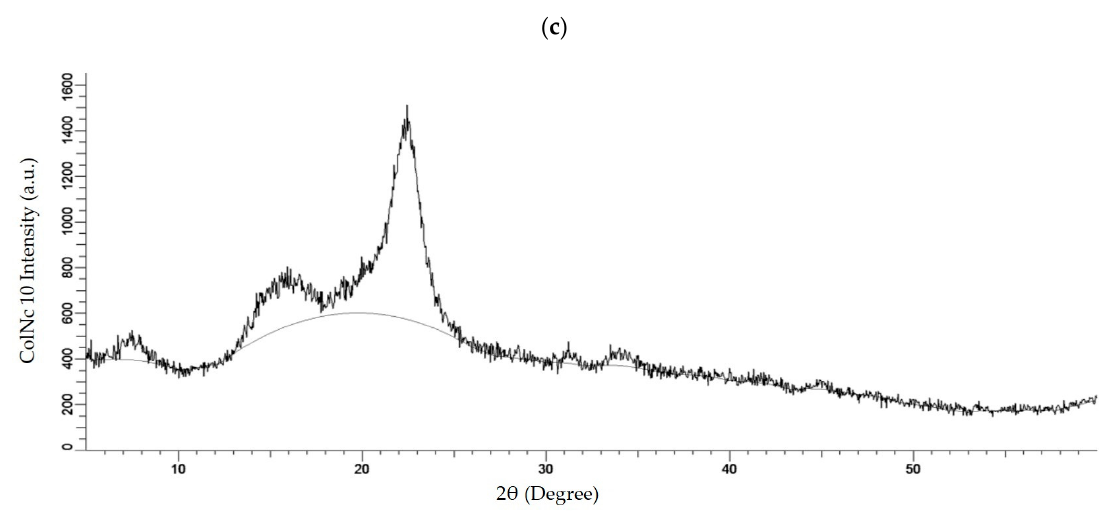
( e ) Figure 5. The XRD molecular pattern of ( a ) POC (Control); ( b ) 1 mL collagen with 1 mg nanocellulose (ColNc 1); ( c ) 1 mL collagen with 5 mg nanocellulose (ColNc 5); ( d ) 1 mL collagen with 10mg nanocellulose (ColNc 10); ( e ) nanocellulose.